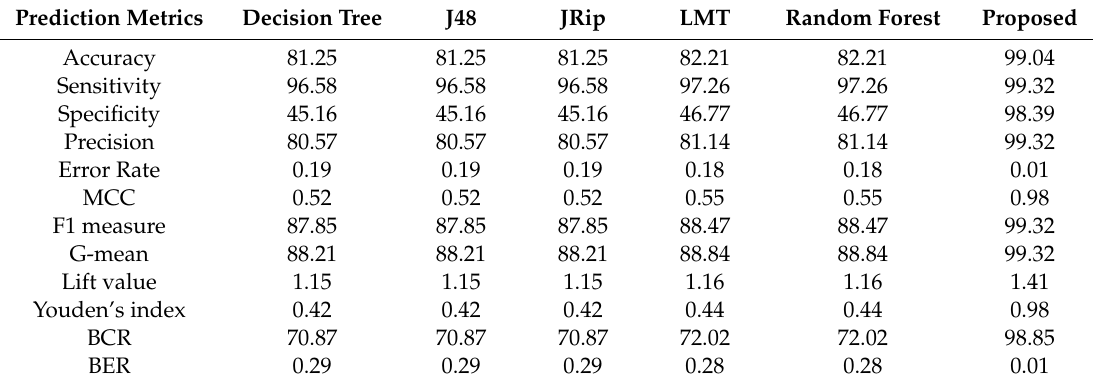
Table 8. GLCM_90 dataset.